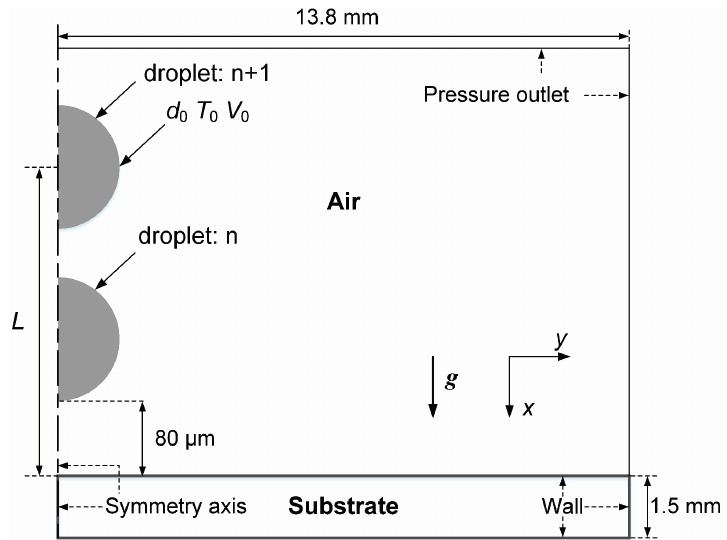
Figure 2. Boundary conditions and computational